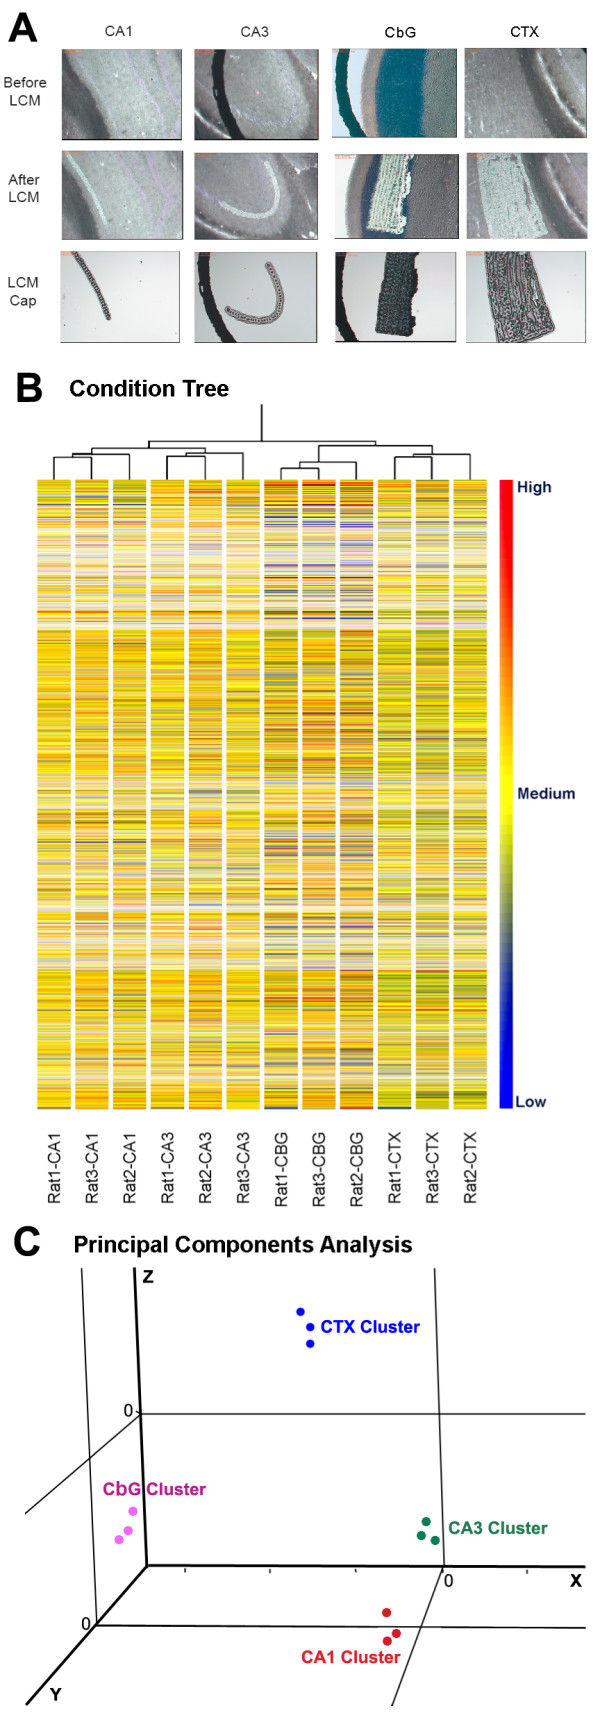
LCM of neurons from the pyramidal cell layers of CA1 and CA3 of hippocampus, CbG cells of cerebellum, and layers IV-VI of cerebral cortex, and condition tree and Principal Components Analysis of microarray data from the captured neurons. (A) LCM capture of neurons from the four brain regions. The upper row shows the lightly stained populations of neurons in the respective brain sections, the middle row shows the image of the sections after neuronal capture by LCM, and the bottom row shows the captured neurons on the LCM cap. (B) Condition tree analysis of microarray data. Condition tree analysis was based on expression values of all probesets on the Affymetrix RAE230A GeneChip (color bar shown at right indicates relative gene expression levels). Pearson correlation was used as measurement of similarity. (C) PCA of microarray data. This analysis allowed for the visualization of the relationships among samples from the four brain regions.